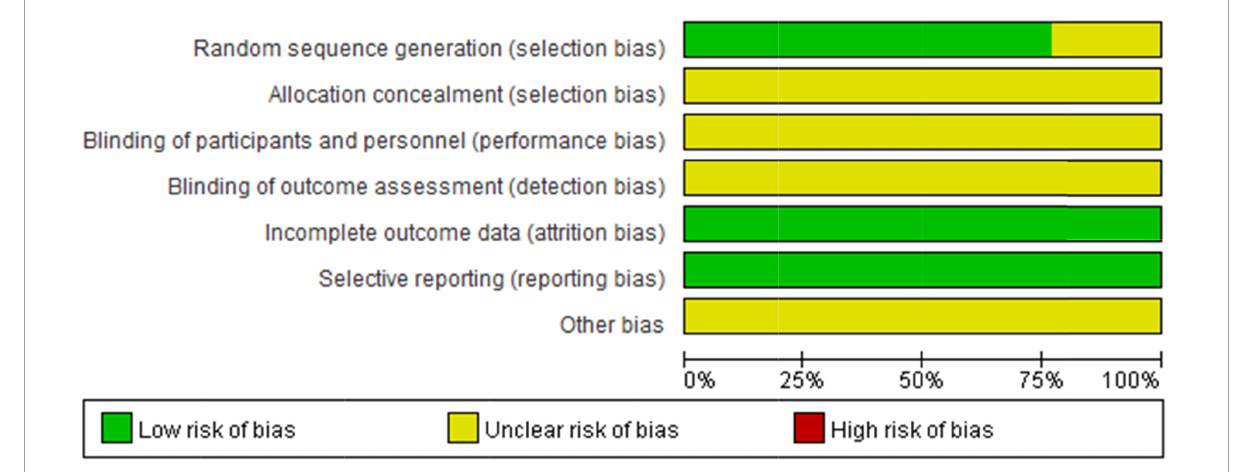
Frontiers in Medicine